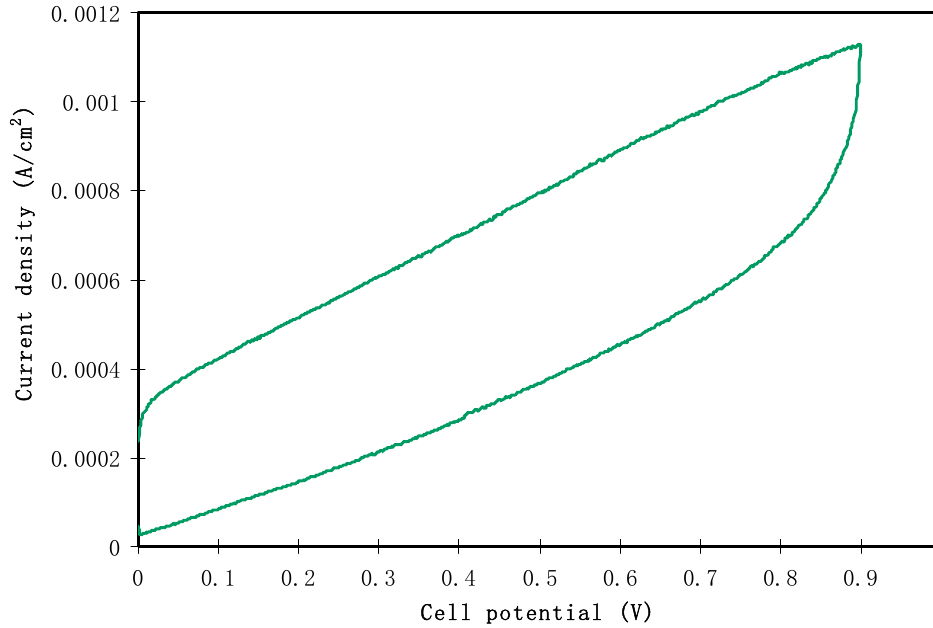
Figure 7. Cyclic voltammetric plot of the constructed EDLC in the potential range from 0 to 0.9 V at 50 mV s − 1.